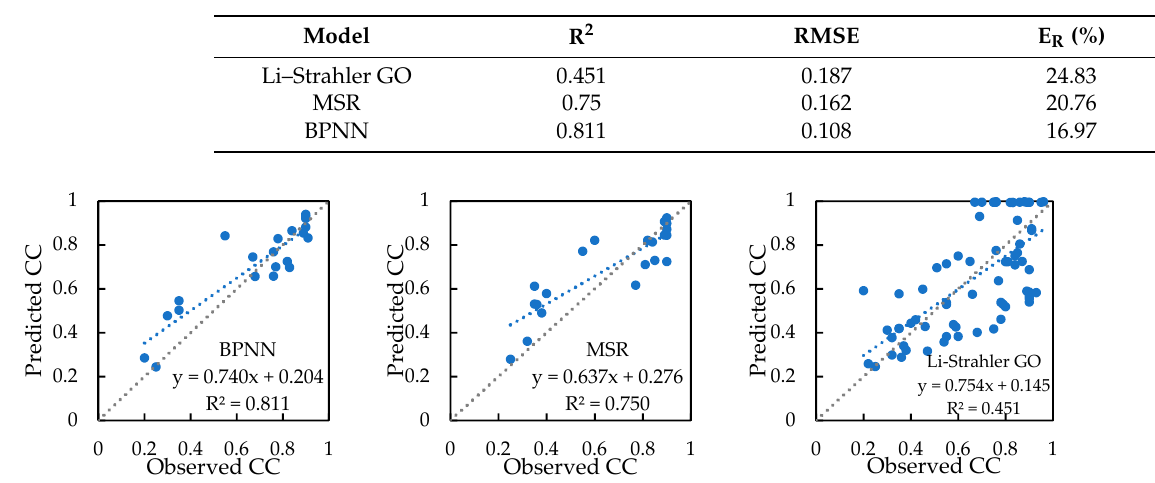
Table 17. A comparison of model accuracy validation.